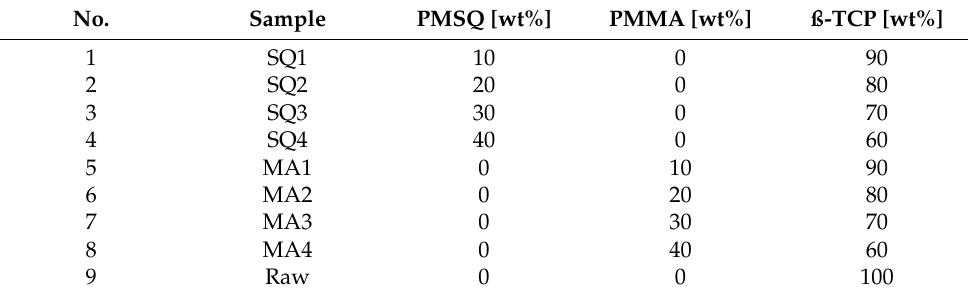
Table 1. Slurry composition of the 70 wt% solid